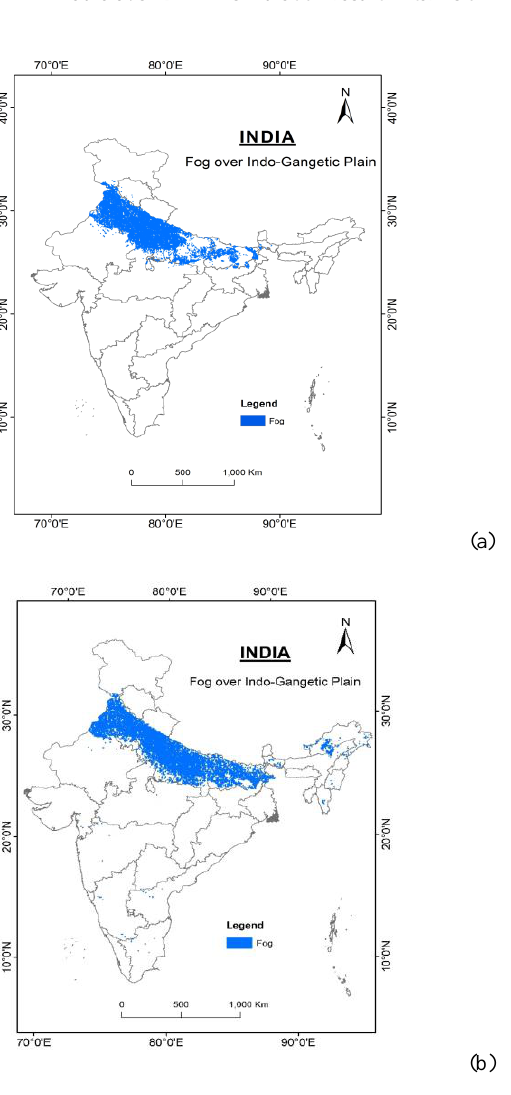
Table 3. SBDART simulation result in terms of BT for different fog microphysical